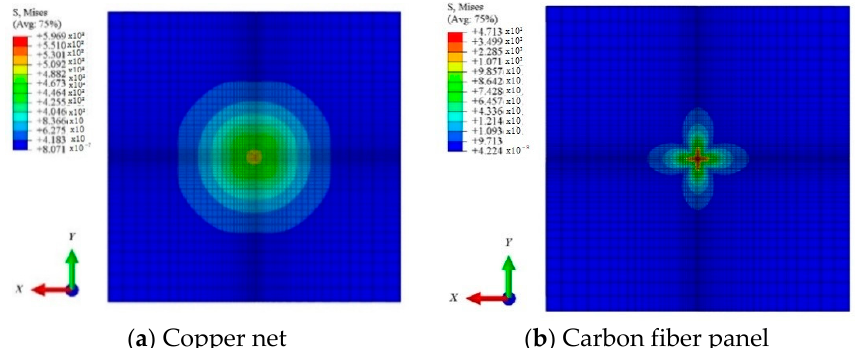
Figure 3. Stress nephogram of 100 kA multi-field coupling simulation.